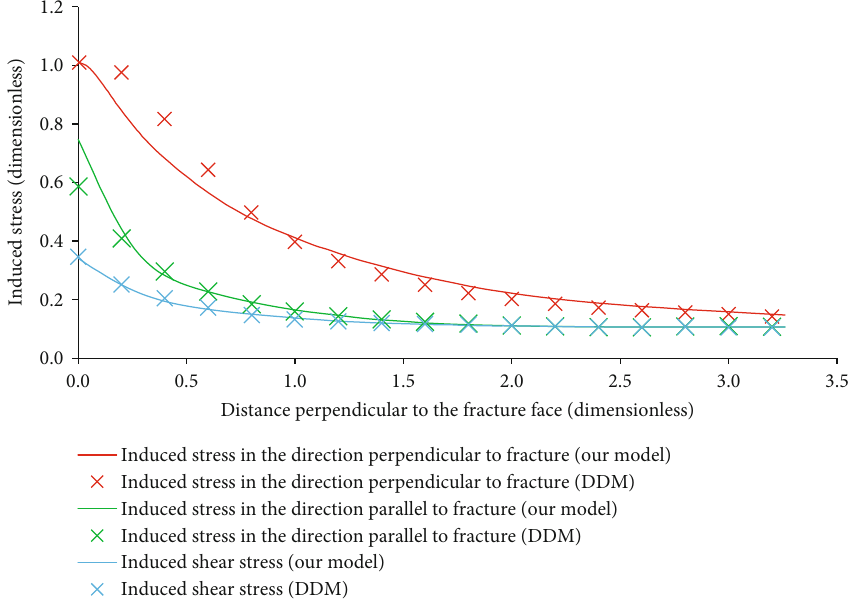
Figure 7: Relationship between the induced stress (dimensionless) of a single crack and the distance (dimensionless) perpendicular to the crack surface.